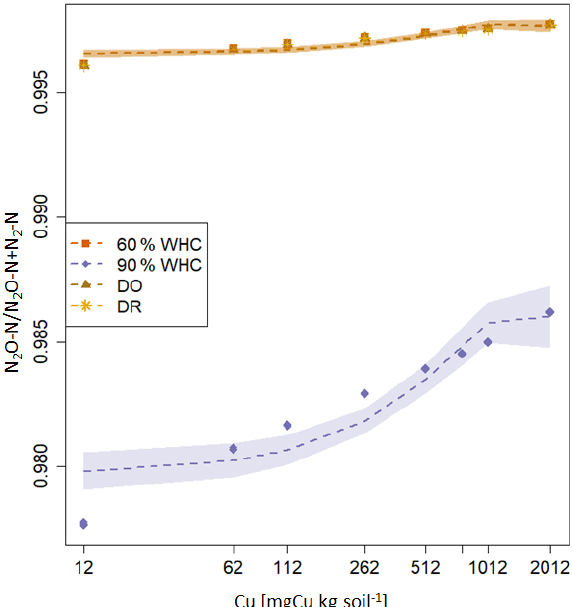
Figure 6. Proportion of N 2 O-N emitted arising from the denitrifica- tion calculated as N 2 O-N / N 2 O-N + N 2 − N modelled fluxes in re- sponse to soil Cu concentration for the various moisture treatments. The red square is for 60% WHC, purple diamond is for 90% WHC, yellow circle for Dry-Rewet (DR) and brown star for Dry-Only (DO). Red, yellow and brown curves are superposed. Fluxes were modelled for 12, 62, 112, 262, 512, 762, 1012 and 2012mgCukg − 1 of soil as represented by stars. Quadratic fits were used for repre-